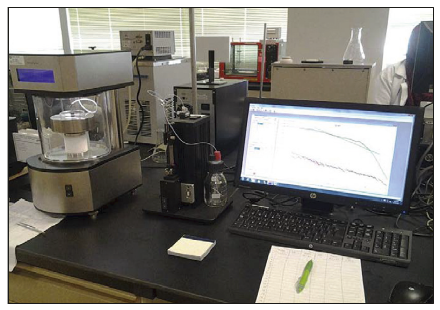
Figure 5: Dynamic contact angle device.